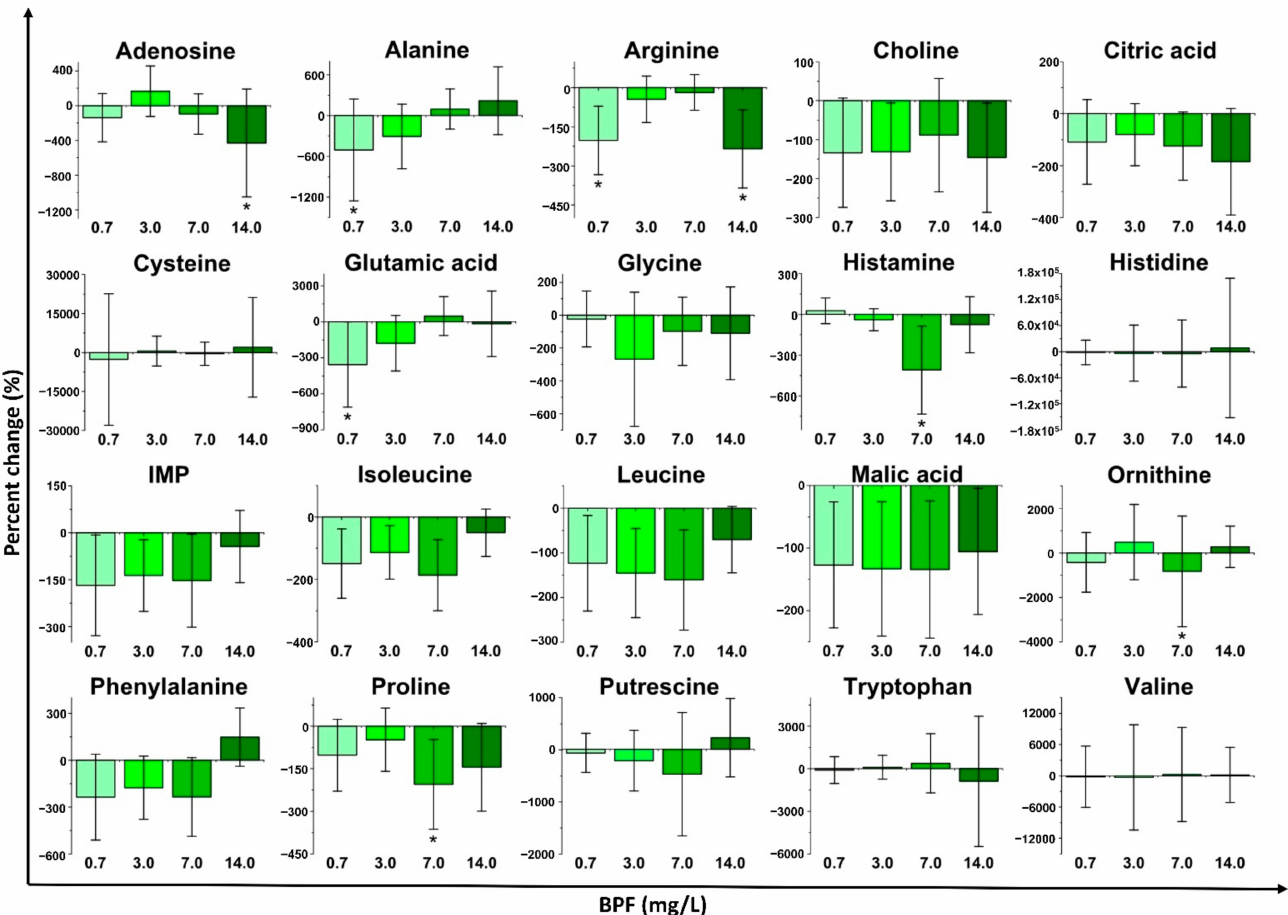
Figure 3. Metabolite percent changes of D. magna exposed to bisphenol F (BPF) at fractions of median effective concentration (EC 50 ) values. The percent changes of the contaminant exposure are relative to a control. ( n = 10 and * p ≤ 0.05). IMP = inosine